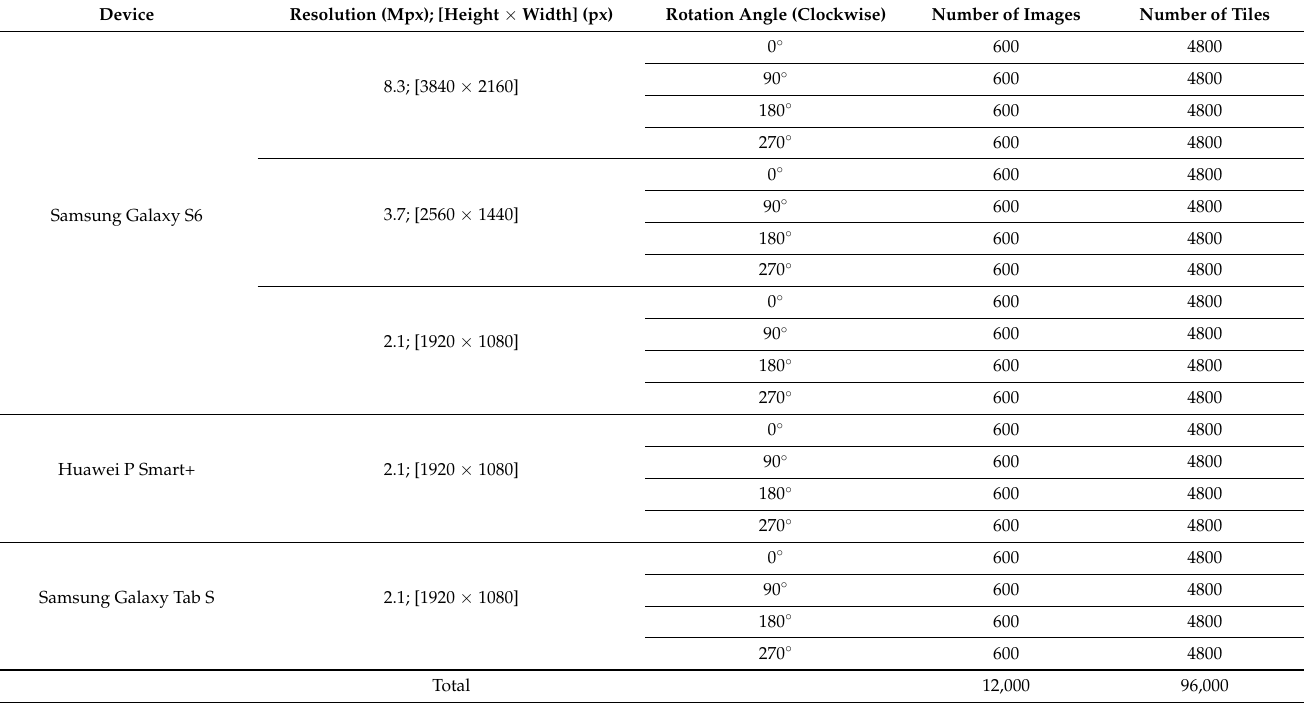
Table 4. Specifications of the tactode_big test